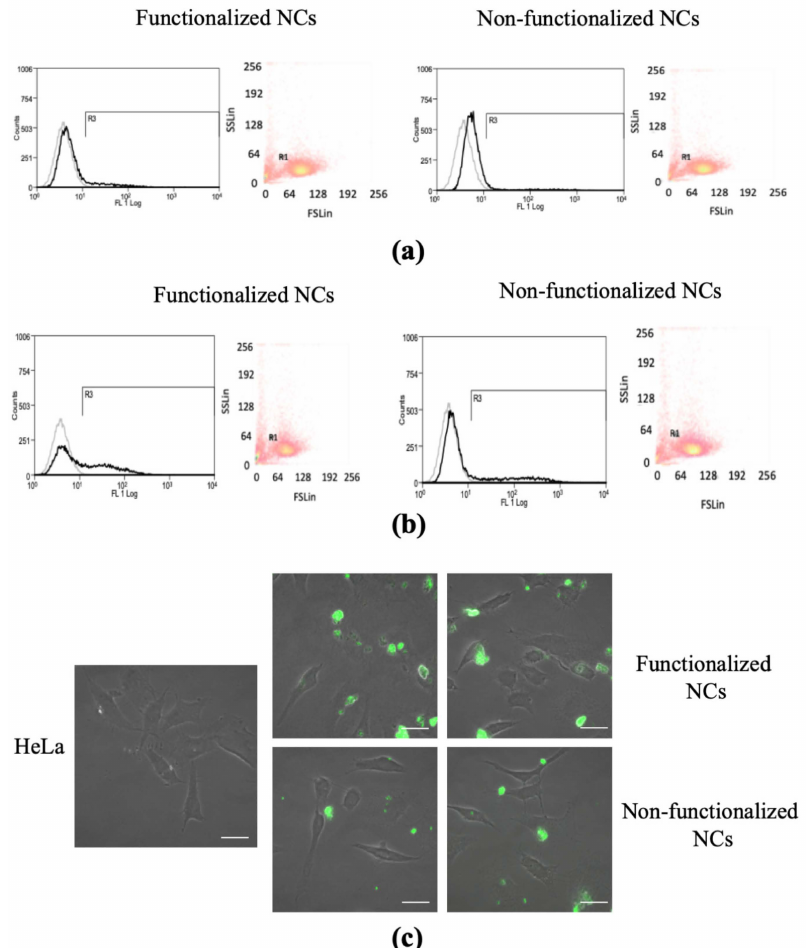
Figure 6. Cell uptake test. Fluorescence-activate cell sorting (FACS) analysis representing the dot plots of physical cell parameters and histogram plots of fluorescence emitting HeLa cells after ( a ) 6-h and ( b ) 24-h incubation with functionalized and non-functionalized NCs. Black histograms represent cells stained with 100 µ g/mL − 1 NCs. Gray histograms represent unstained control cells; ( c ) confocal microscopy images of HeLa cells after 24 h of incubation with 100 µ g mL − 1 functionalized and non-functionalized NCs. Scale bar 20 µ